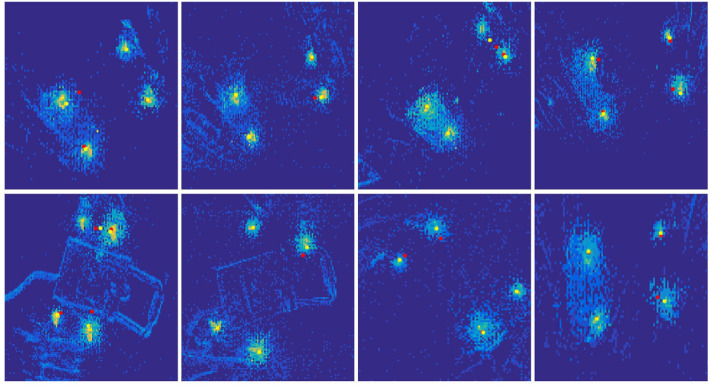
Comparing tracking results between spatiotemporal mixed particle filter and general particle filter. The yellow stars present the tracked LED positions from spatiotemporal mixed particle filter; the red stars present the tracked LED positions from general particle filter (only with temporal evidence).